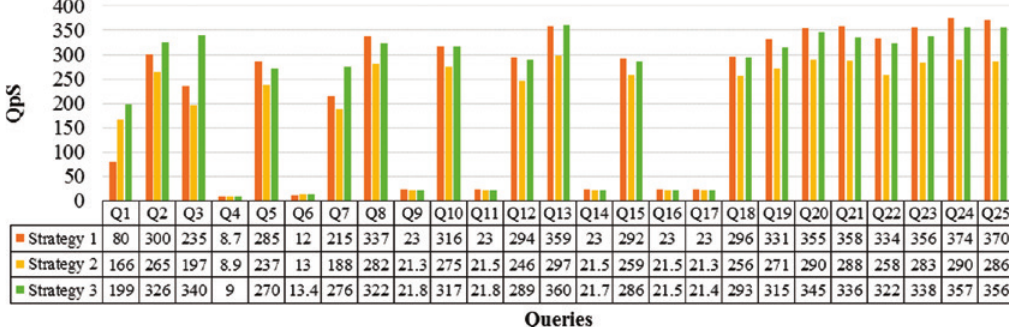
Figure 8: QpS Analysis of Three Strategies on Three Ontologies and A-BOX of Size 1L.